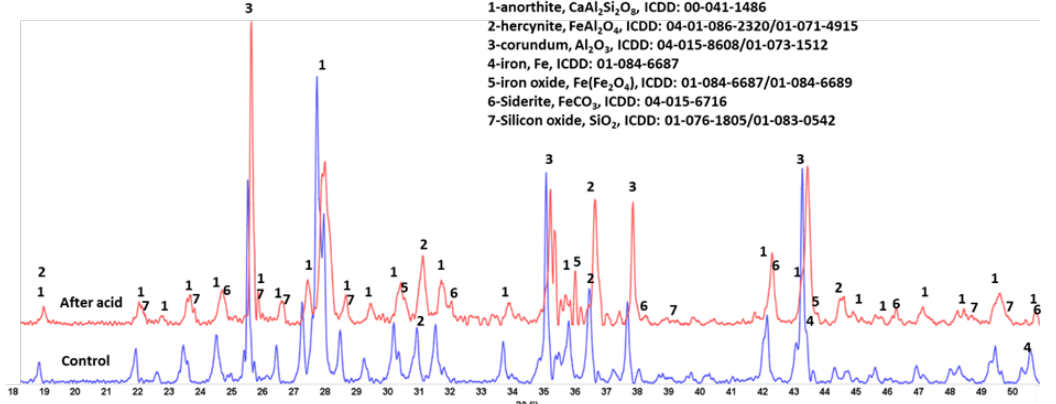
Figure 15. XRD patterns of the control (250 °C autoclaved) and acid-exposed mullite samples.